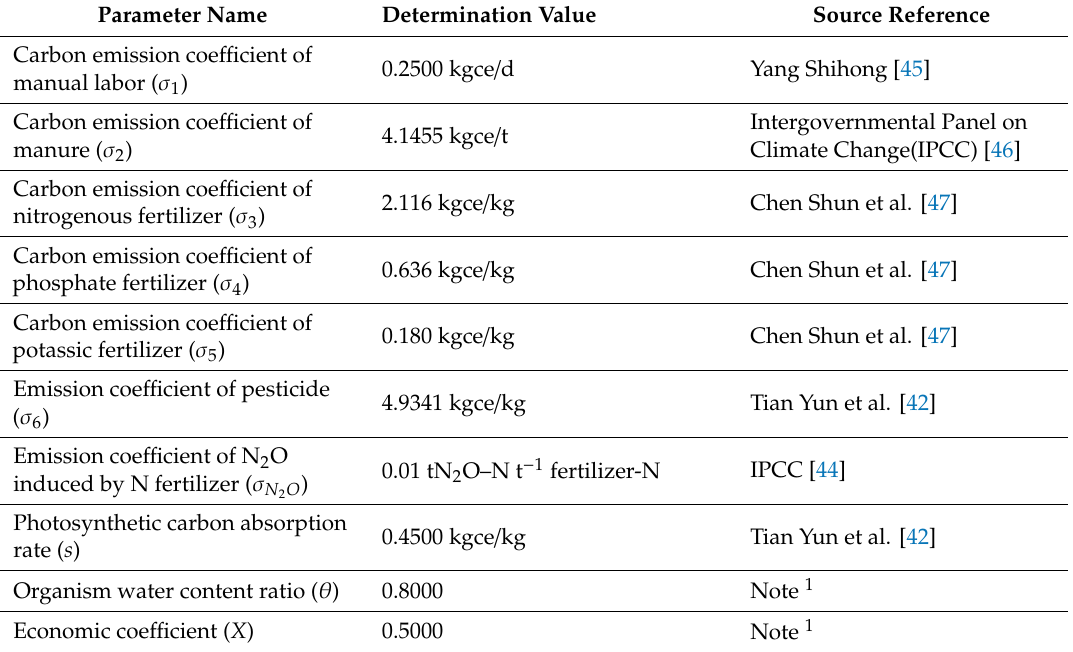
Table 1. Parameters in the formulas of carbon emission and carbon sequestration sunk by photosynthesis in mulberry